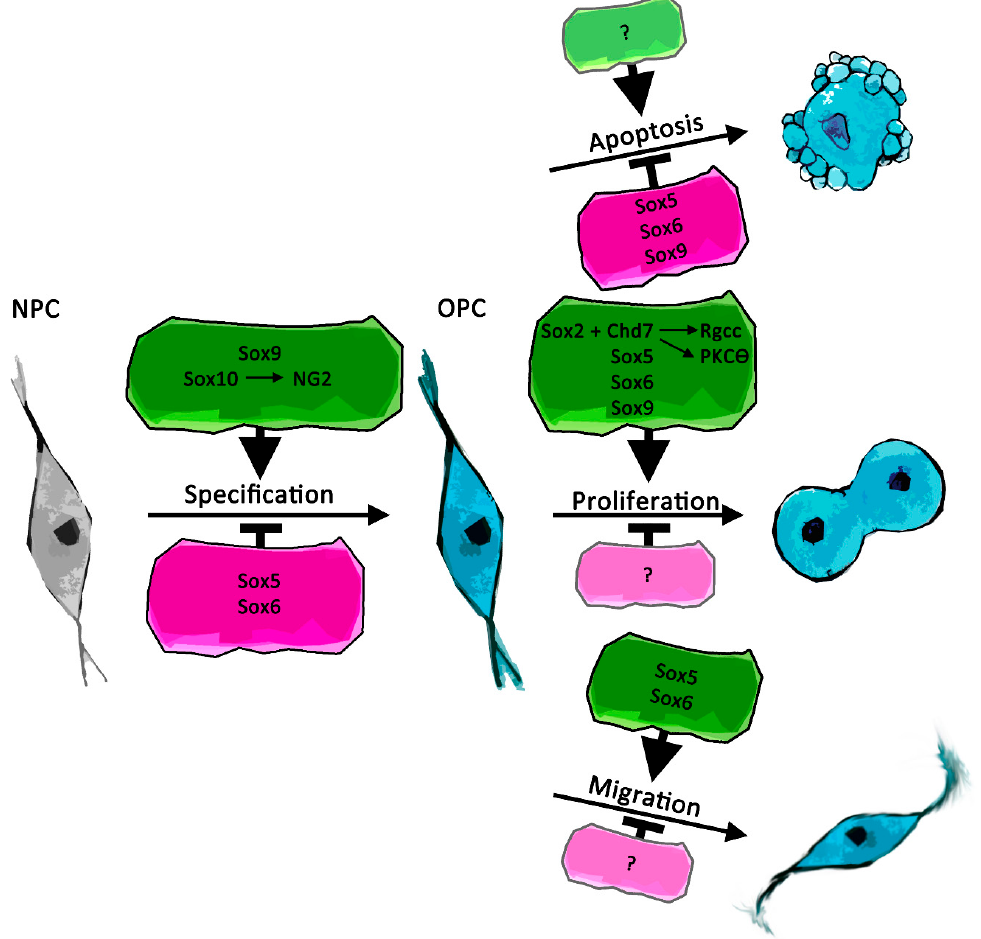
Figure 1. Schematic representation of recently described Sox protein functions during specification, proliferation, and migration of oligodendrocyte precursor cells (OPCs) as well as in regulation of apoptosis. Positive effects are depicted in green, negative effects in magenta. Arrows in colored frames indicate regulators of Sox protein expression as well as mediators of Sox protein function. Interaction partners of Sox proteins are additionally annotated by “+”. NPC = neural precursor cells.